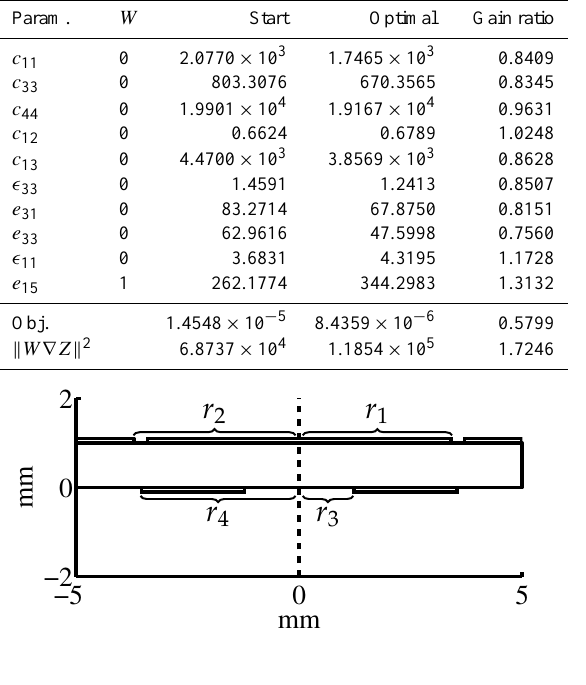
Table 2. Binary weights: improvement of sensitivity of impedance w.r.t. material parameters using W = diag(0 , 0 , 0 , 0 , 0 , 0 , 0 , 0 , 0 , 1). The sensitivity w.r.t e 15 has increased. However, the sensitivity to- ward other parameters has mainly decreased. Objective function values are shown unscaled. Figure shows resulting geometry util- ising binary weight matrix in millimetres; r 1 = 3 . 4 ; r 2 = 3 . 7 ; r 3 = 1 . 23 ; r 4 = 3 . 54.